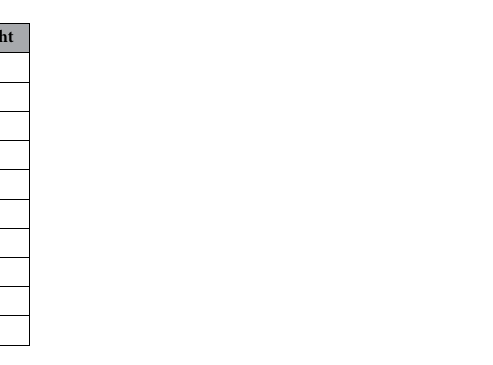
Table 3. Nano-scale surface height change: transverse profile in terms of cell surface roughness.